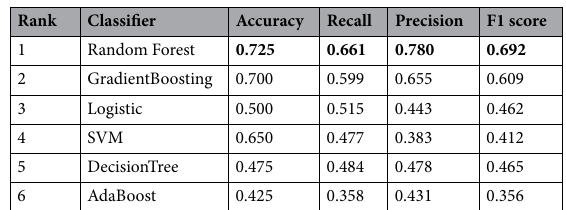
Table 6. Results of the choosing the ML model. Significant values are in bold.